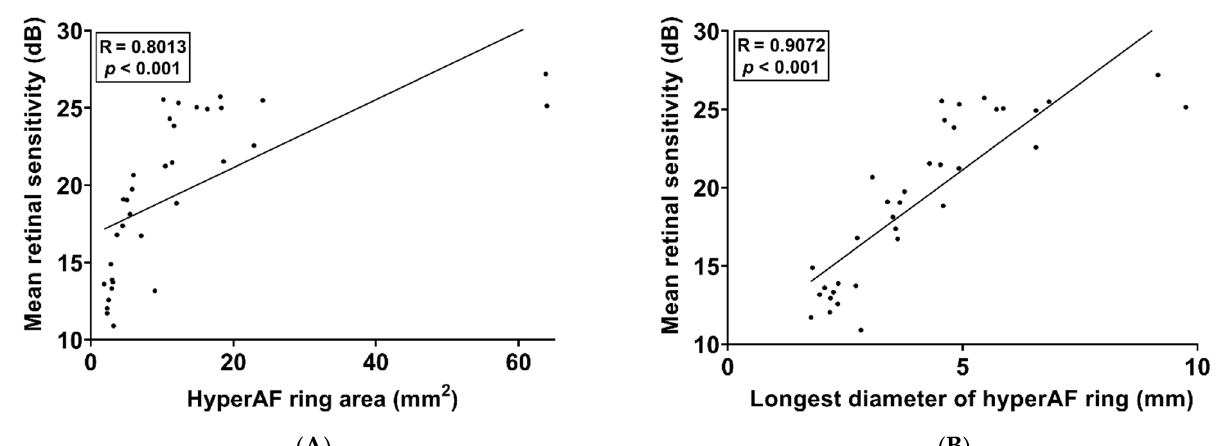
Figure 3. Scatterplots with linear regression analysis showing the correlation of the mean retinal sensitivity with the hyperautofluorescent (hyperAF) ring area ( A ) and the longest diameter of the hyperAF ring ( B ).